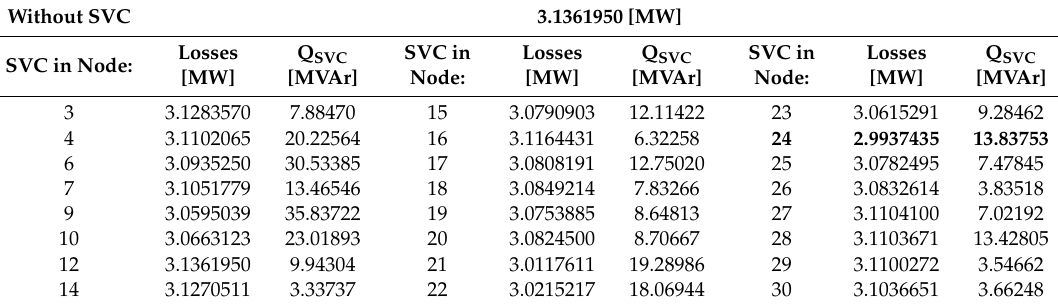
Table 3. Power losses (MW) without and with SVC in the IEEE 30 test bus system—CASE 1. Without